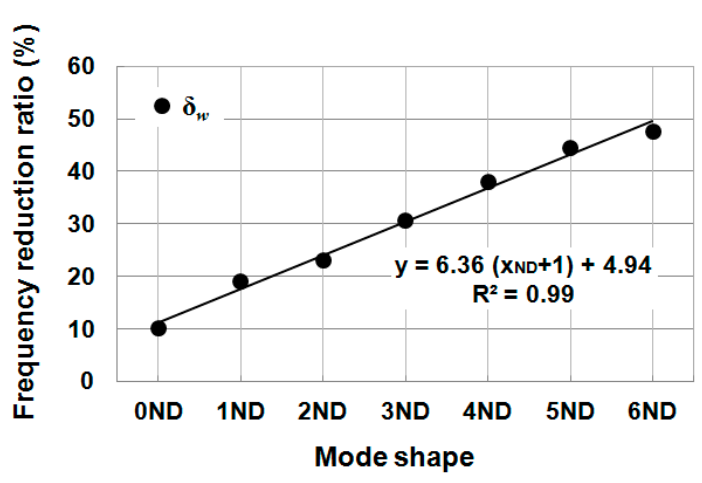
Figure 13. Natural frequencies of the runner in air and in water.